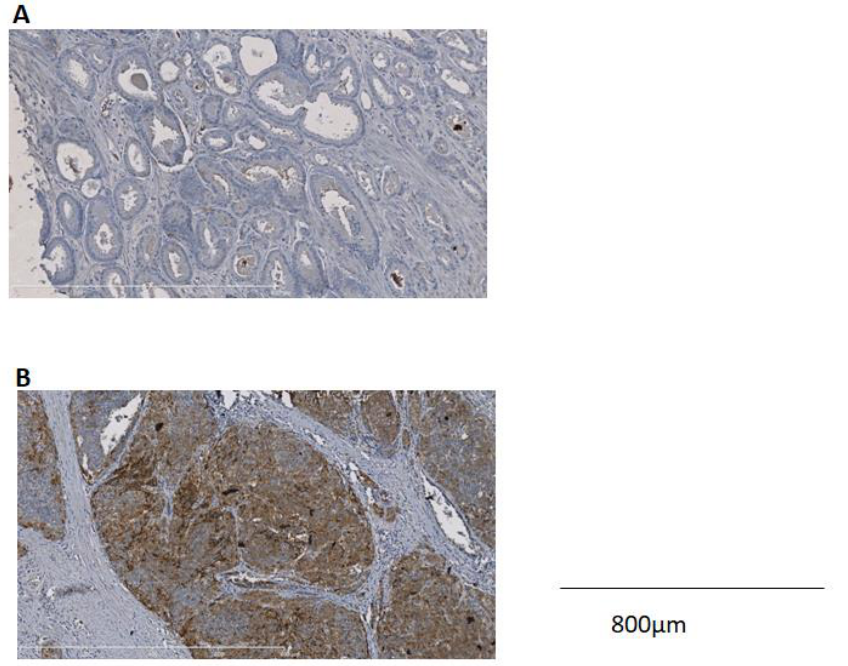
Figure 2. Expression profiles of NTR 1 in prostate cancer. ( A ) No NTR 1 expression in Gleason 6 prostate cancer. ( B ) Strong NTR 1 staining in Gleason 8 prostate cancer. Images were obtained with 10× magnification.